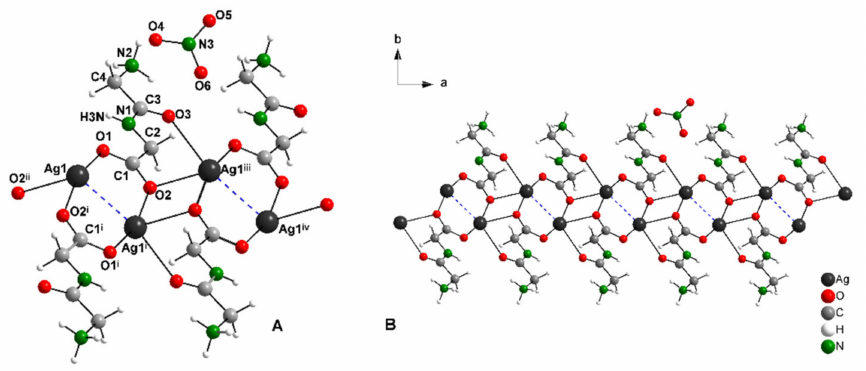
Figure 1. Structure motif ( A ) and solid-state packing viewed along [0 0 1] ( B ) for AgGlyGly (i = − x, − y, − z + 3; ii = x − 1,y,z; iii = x + 1, − y,2 −